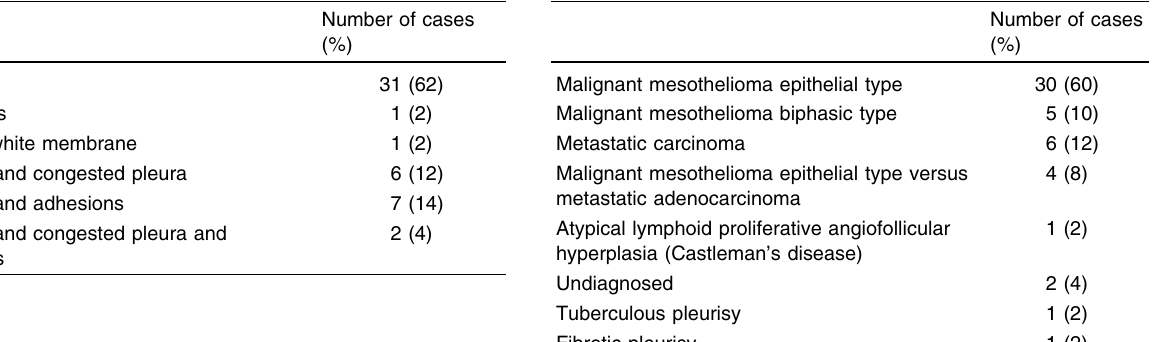
Table 5 Thoracoscopic findings of the studied cases Table 6 Final diagnosis